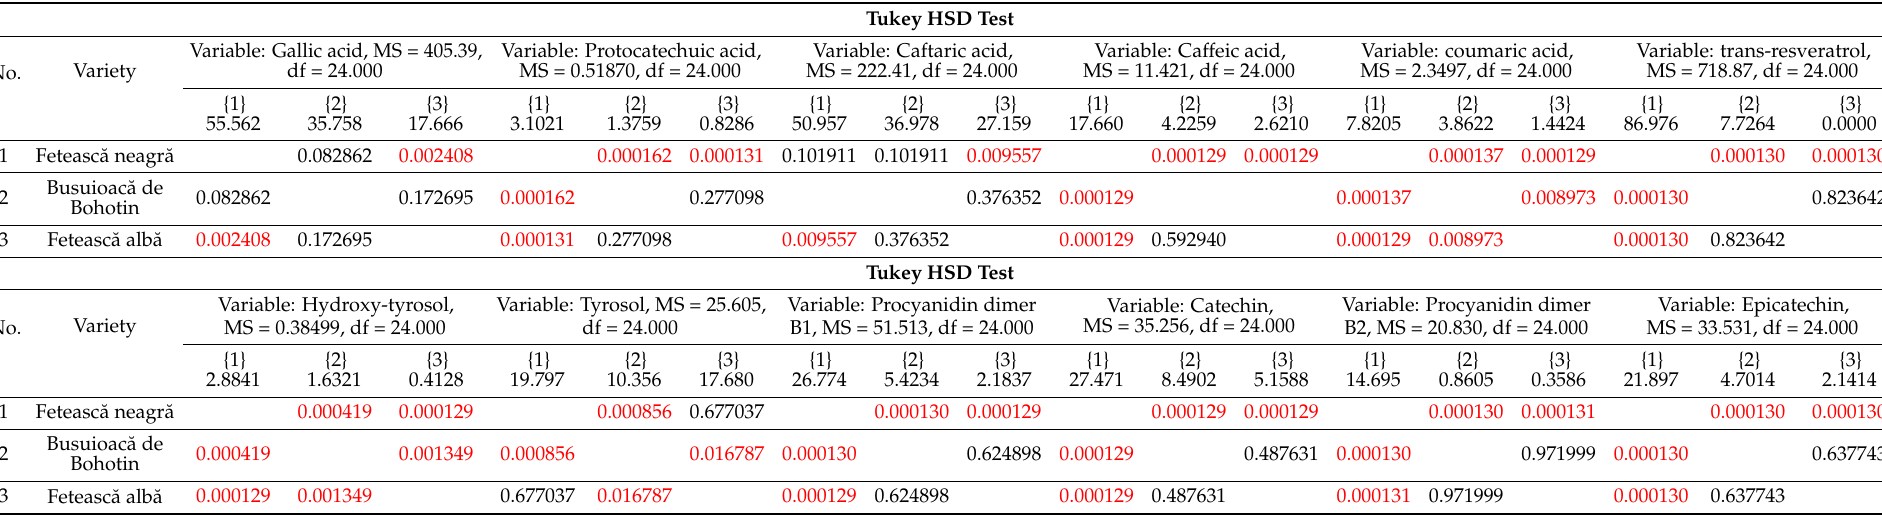
Table 6. Tukey HSD test results.